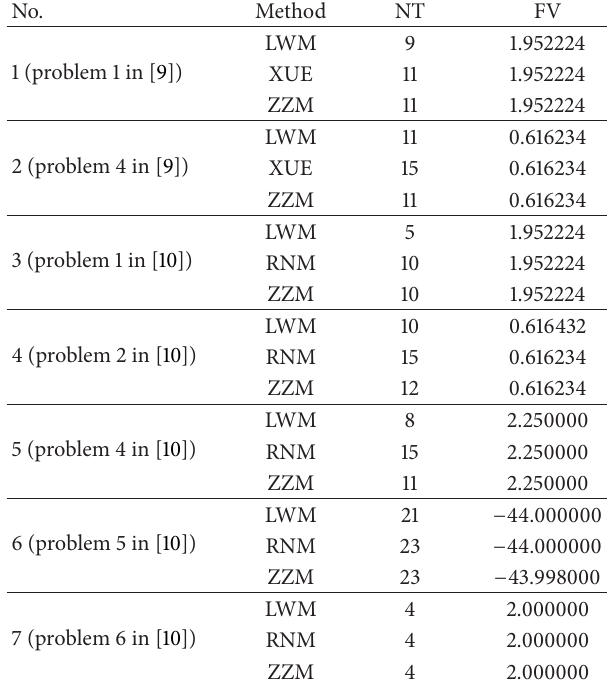
Table 2: Test results obtained by Algorithm A and other relearnt